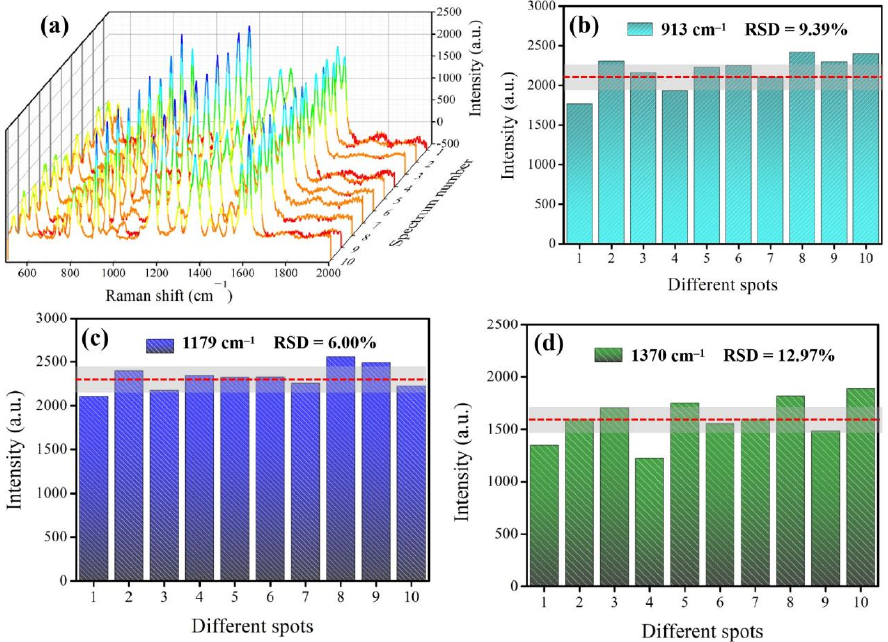
Figure 9. ( a ) Raman spectra of 10 −10 M CV solution collected from 10 randomly selected substrates; ( b – d ) the Raman signal histograms at the characteristic peaks of 913, 1179 and 1370 cm −1 and the corresponding RSD values.